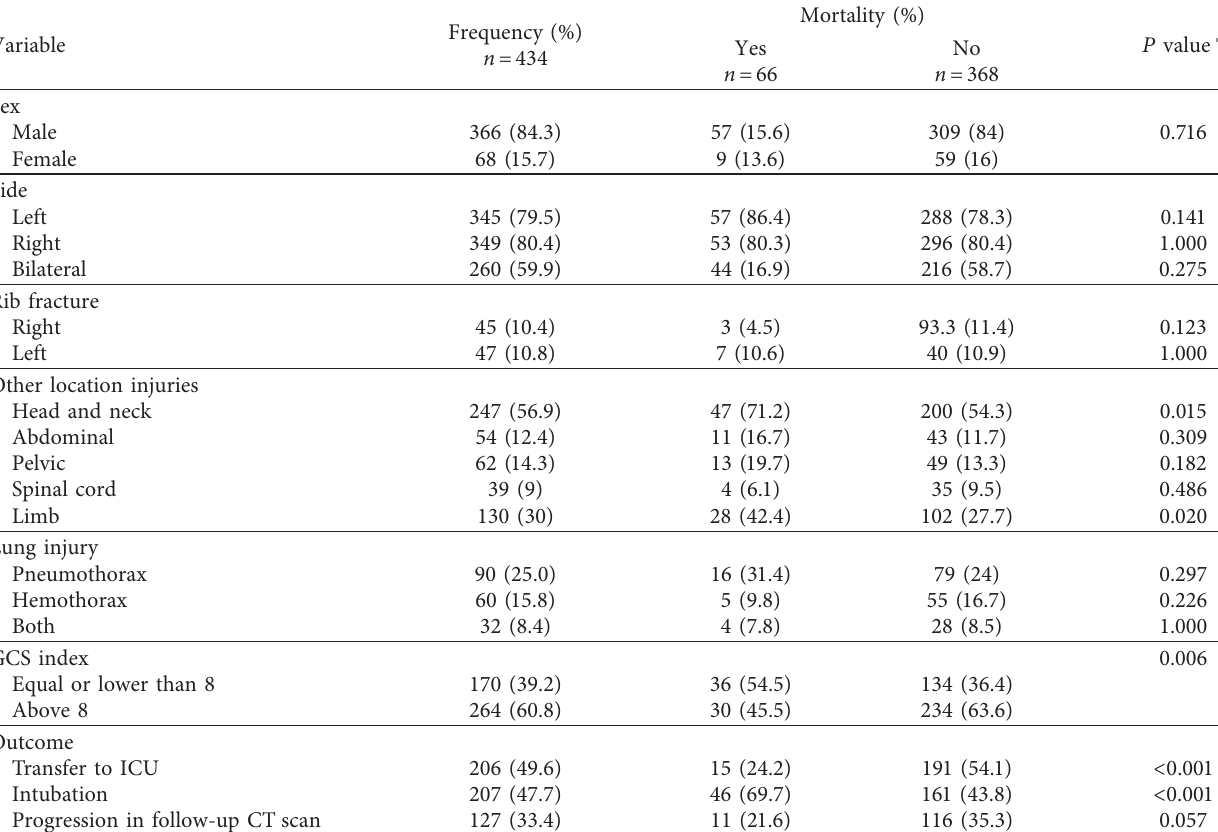
Table 1: Clinical features and outcomes of lung contusion patients in southern